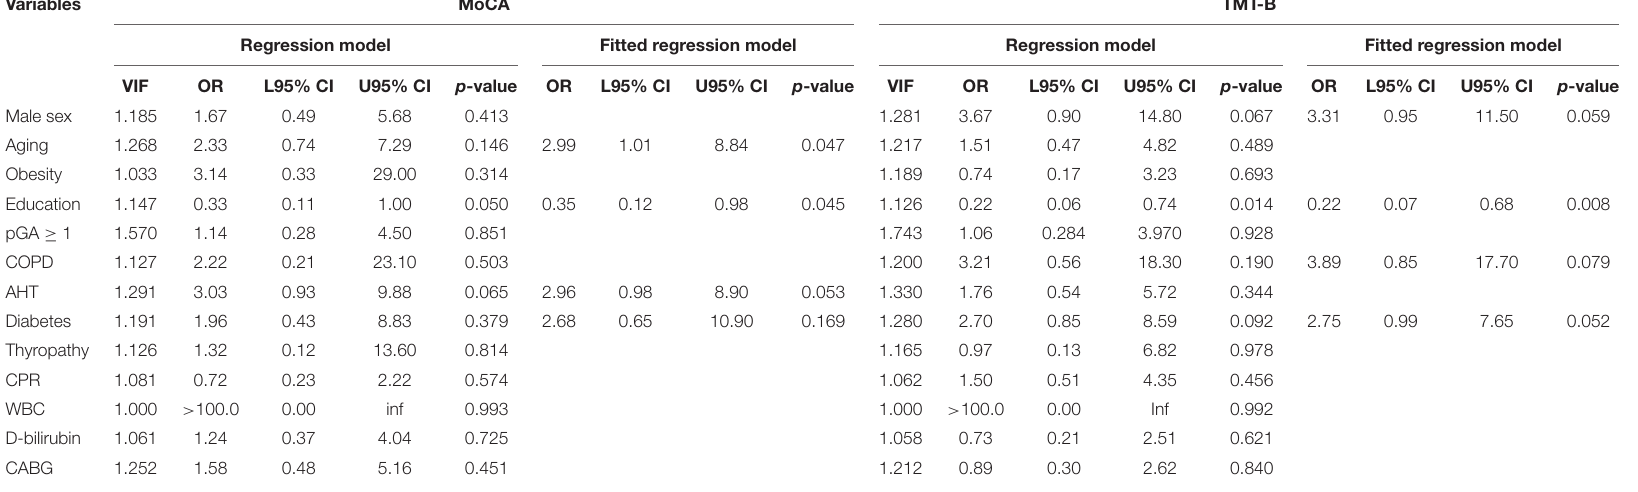
Multiple linear regression analysis was performed to explain the relationship between one dependent variable [Montreal Cognitive Assessment (MoCA score ≤ 25) and Trail-Making Test B (TMT-B score ≥ 283s or inability to complete the test in 7min) tests] and independent variables [sex, aging (age ≥ 65 yrs), obesity (body mass index, BMI ≥ 30 kg · m 2 ), education ( ≥ 10 yrs), past general anesthesia (pGA), chronic obstructive pulmonary disease (COPD), arterial hypertension (AHT), diabetes, thyropathy, c-reactive protein (CPR > 2.9 mg · L − 1 ), white blood cells count (WBC > 11 × 10 9 · L − 1 ), bilirubin direct (D-bilirubin > 5.1 umol · L − 1 ), surgery type (coronary artery bypass graft, CABG, compared to valve surgery)]. Multicollinearity was not detected using variance inflation factors (VIF). Using the Akaike Information Criterion, backward/forward stepwise regression analysis was performed to choose the best model [the fitted regression model]. OR, odds ratio; L95%, lower limit of the 95% confidence interval (CI); U95%, upper limit of the 95% CI. Statistical significance was set at p-value <